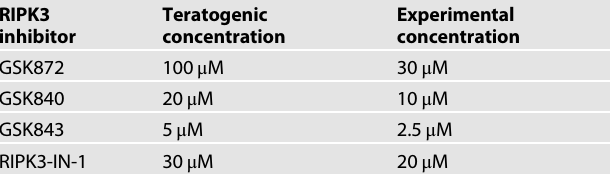
Table 1. The concentrations of RIPK3 inhibitors used.